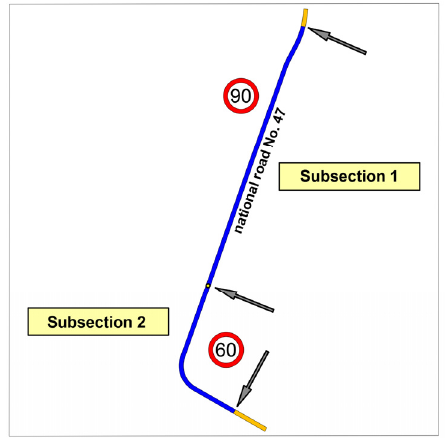
Figure 8. Analyzed section of the road divided into two subsections with speed limits of 90 km/h and 60 km/h.